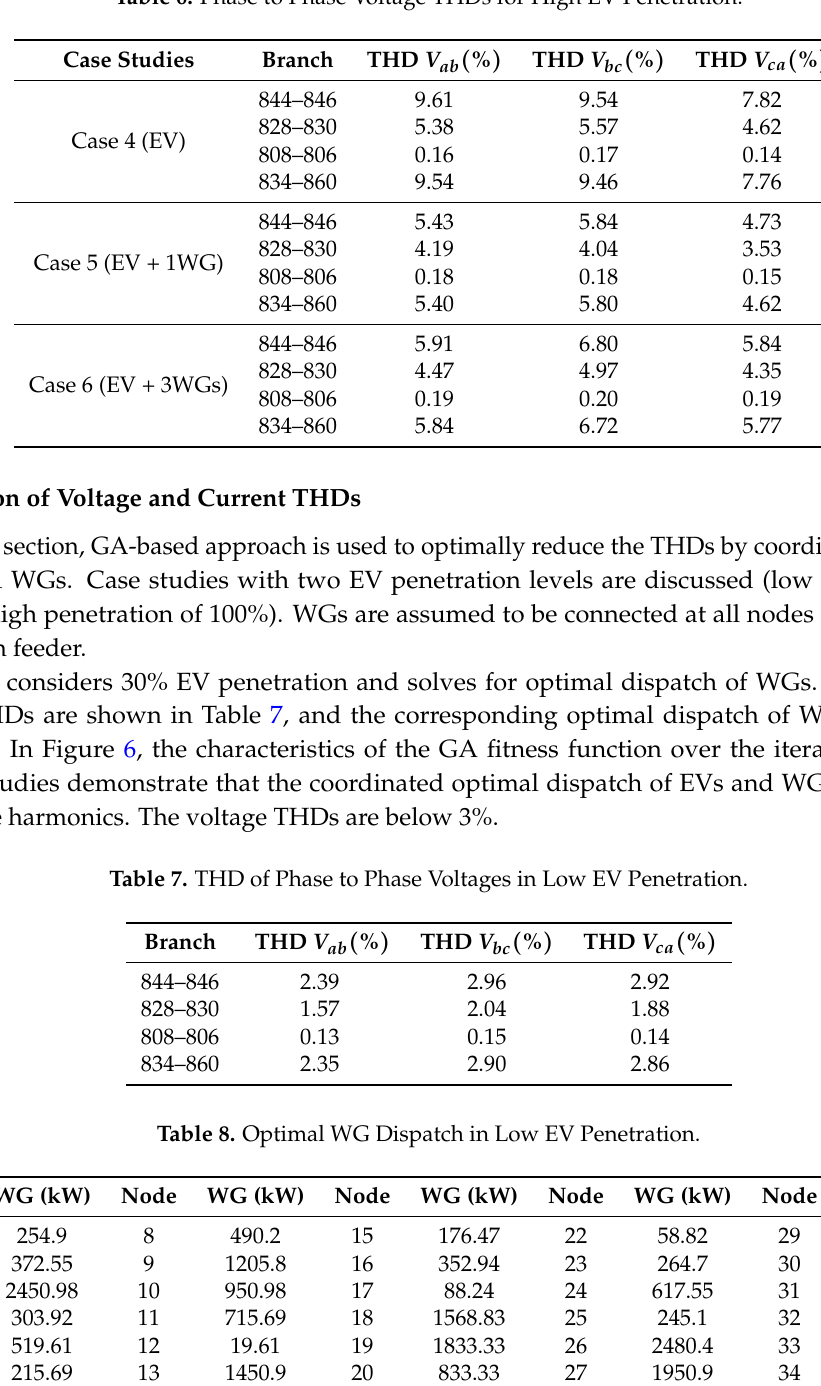
Table 6. Phase to Phase Voltage THDs for High EV Penetration.